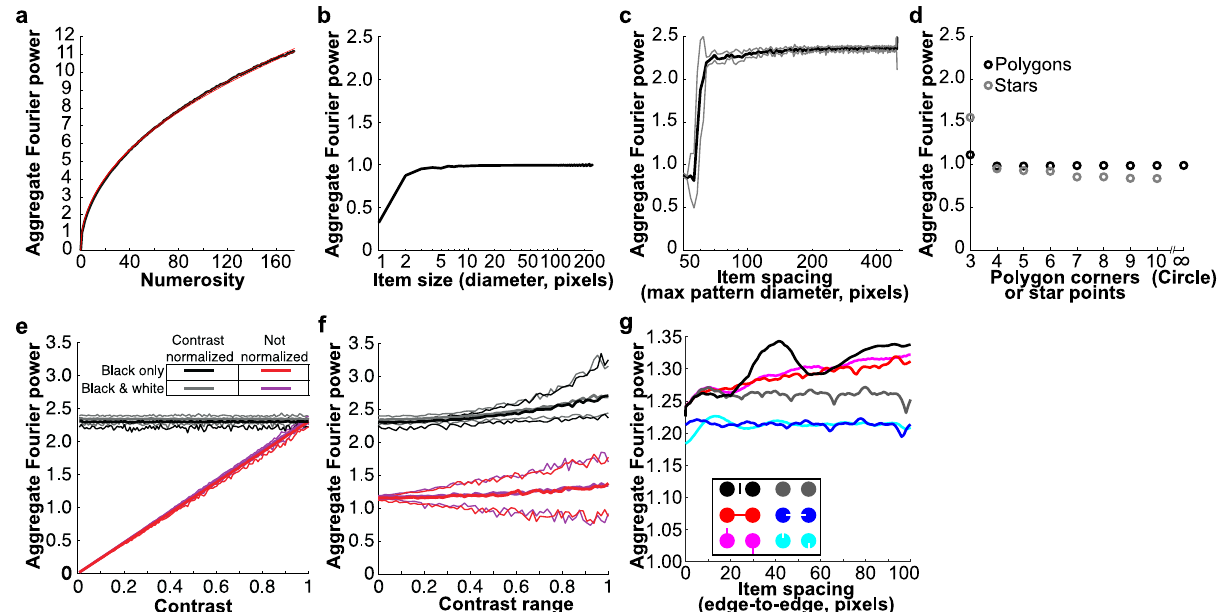
Fig. 4 Aggregate Fourier power followed numerosity closely with little effect of item size, spacing, shape, contrast, or connectedness. a Aggregate Fourier power as a function of numerosity for a fi xed item size (black line). Red lines show y = x 0.466 and y = x 0.470 , which approximate the observed relationship. b Aggregate Fourier power of one circle of different diameters was approximately constant for diameters above 3 pixels: smaller circles were inaccurately rendered. c Aggregate Fourier power for a group of seven circles (each 16 pixels diameter) increased slightly with spacing for stimulus area diameters above 70 pixels. Smaller areas had little space between items: at 50 pixels all items touch (Supplementary Fig. 9). Black line shows the mean power across n = 18 example stimulus images per item spacing. Gray lines show the standard deviation across example stimulus images. d Aggregate Fourier power was approximately constant for regular polygons above three corners. Triangles and 3-pointed stars had greater Fourier power than circles, while other stars had less Fourier power. e Aggregate Fourier power for a group of seven circles (each 16 pixels diameter) increased linearly as the absolute Weber contrast of items increased (red). Therefore, normalizing Fourier power by dividing by item contrast gave an approximately constant value for all contrasts (black). Fourier power was slightly higher for a random mixture of black and white items (magenta and gray) than only black items (red and black). Heavy lines show the mean power across n = 80 example stimulus images per contrast. Fine lines show the 95% con fi dence intervals across example stimulus images. f When item contrasts were randomly chosen from a range centered on 0.5 contrast, the mean Fourier power across displays increased only slightly as this range increased. The 95% con fi dence intervals increased considerably. g Effects of connections by a bar and an illusory contour on Fourier power, together with control dot pairs with the same change to the dot but no connection and no reduction in perceived numerosity. Compared to dots alone, bars increased Fourier power while illusory contour inducers reduced Fourier power, regardless of connectedness. Source data are provided as a Source Data fi